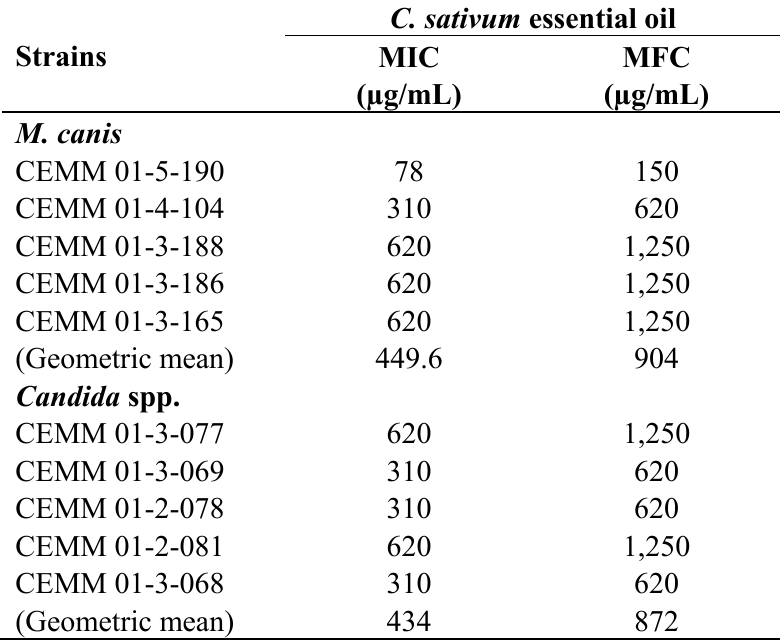
Table 3. Minimum inhibitory and fungicidal concentrations of C. sativum essential oil against M. canis and Candida